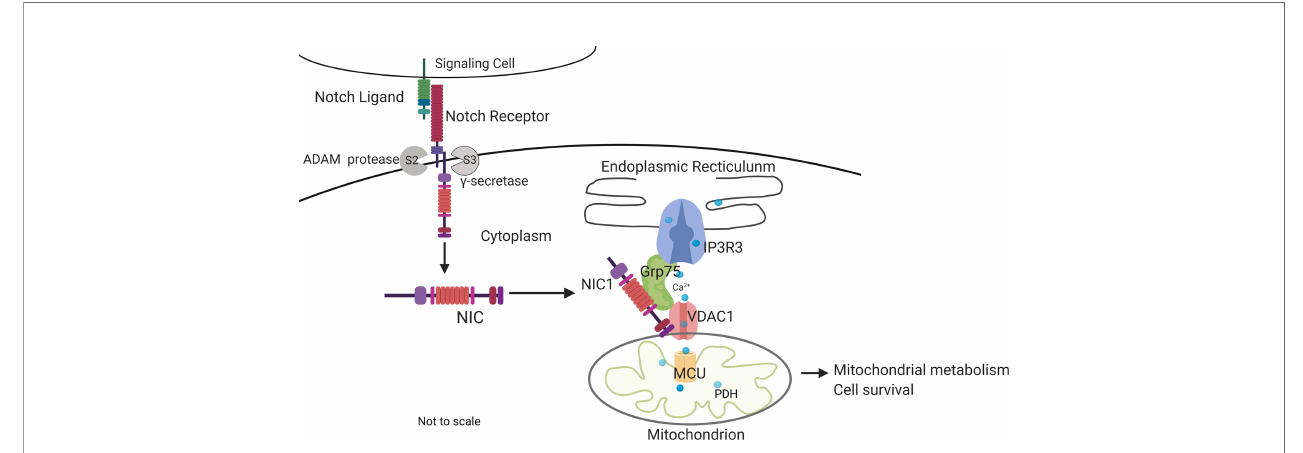
FIGURE 7 | Summary of key outcomes. Non-nuclear localized NIC1 interacts with Grp75 and VDAC1 in a complex that modulates calcium homeostasis in mitochondria with consequences to cellular metabolism and survival. The schematic is not to